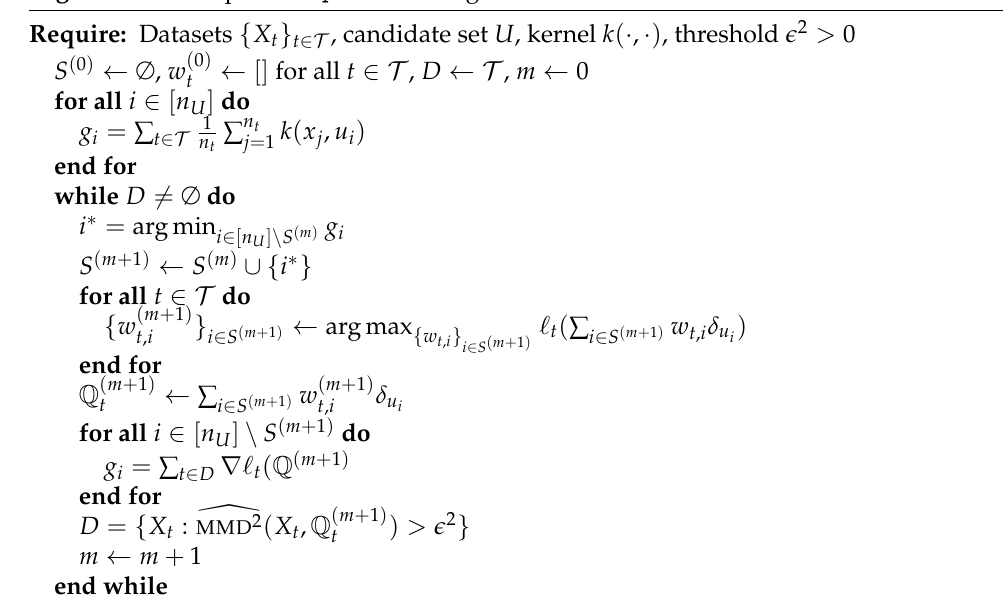
Algorithm 2 A dependent protodash algorithm